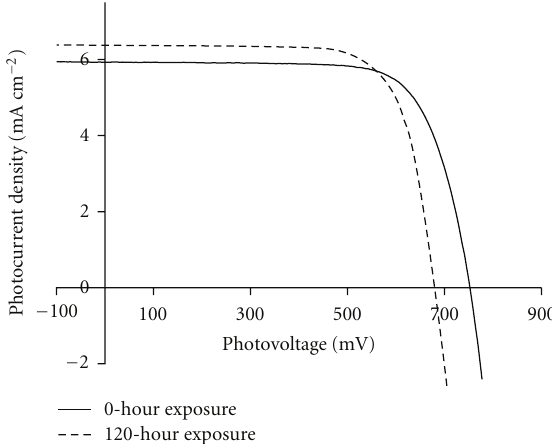
Figure 2: I-V curves of a typical cell at 0-hour and 120-hour UV exposures. It can be seen that V OC has decreased, whilst J SC has increased; however, as can be seen in Figure 1, there is no observable significant changes to cell e ffi ciency.